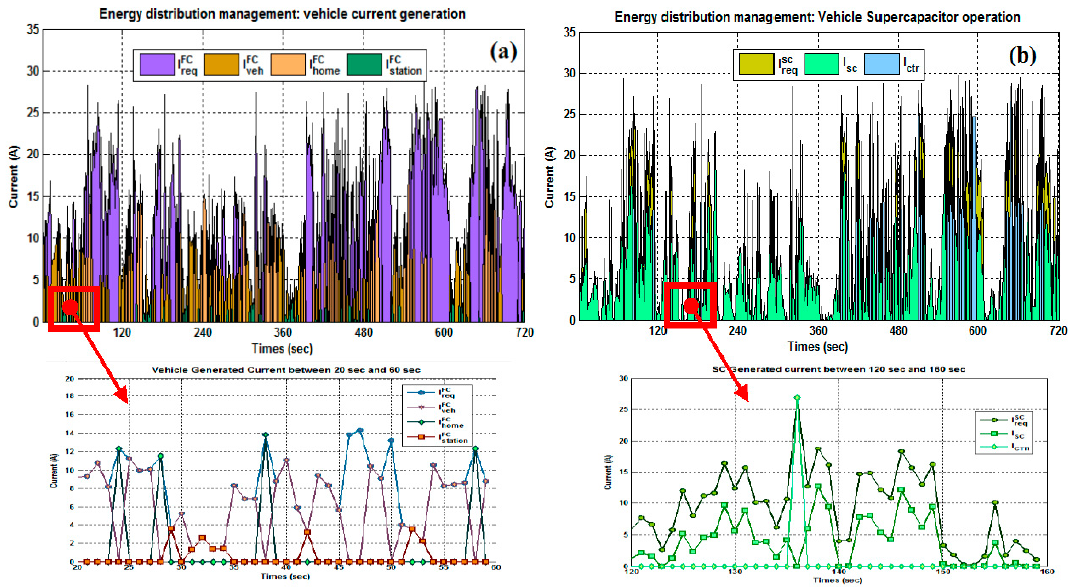
Figure 9. System energy distribution: ( a ) FC current operation per equipment and ( b ) SCap current operation.